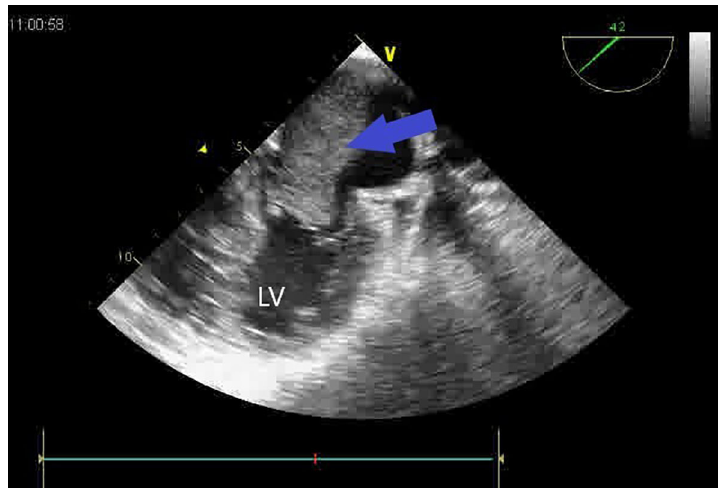
Figure 2. Transesopheagal echocardiography showing alarge mass, occupying nearly all theleftatrium (blue arrow) and mitral obstruction.